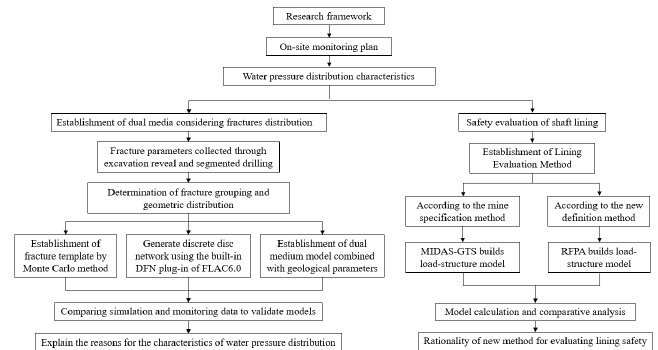
Figure 1. Research ideas. 2. Analysis of Water Pressure Distribution Characteristics Outside the Lining of No. 1 Vertical Auxiliary